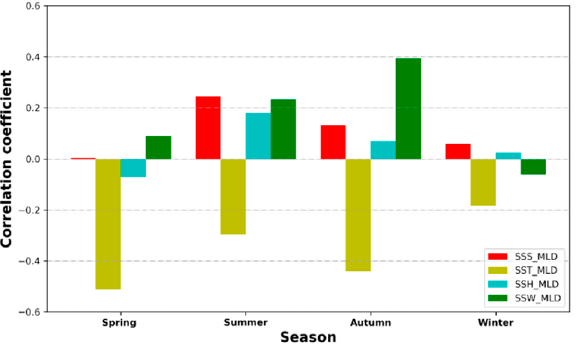
Figure 11. Average annual Pearson correlation coefficients between the estimated MLD and sea ‐ surface parameters (SST, SSS, SSH, and SSW).